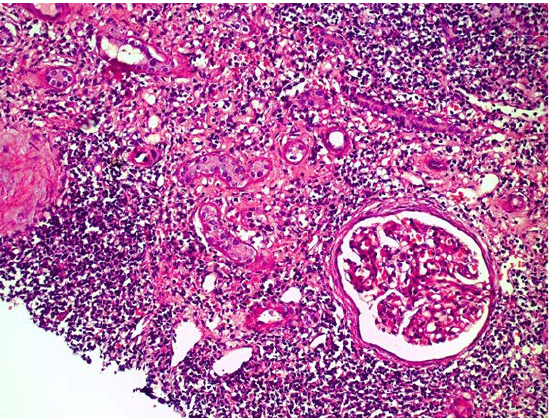
fIguRE 1 – Interstitial lymphomononuclear infiltrate not accompanied by edema and significant tubulitis (dissociation between interstitial and tubular components). Associated tubular atrophy. There is a predominance of small lymphocytes. HE,